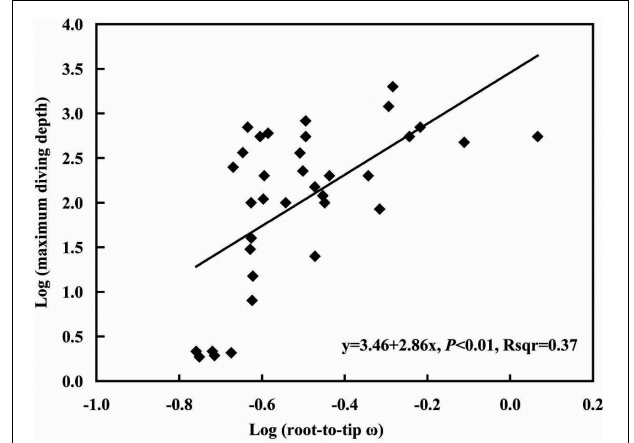
FIGURE 7 | The evolutionary rate of COL8A2 among different maximum diving depths. FIGURE 8 | Association between root-to-tip ω and maximum diving